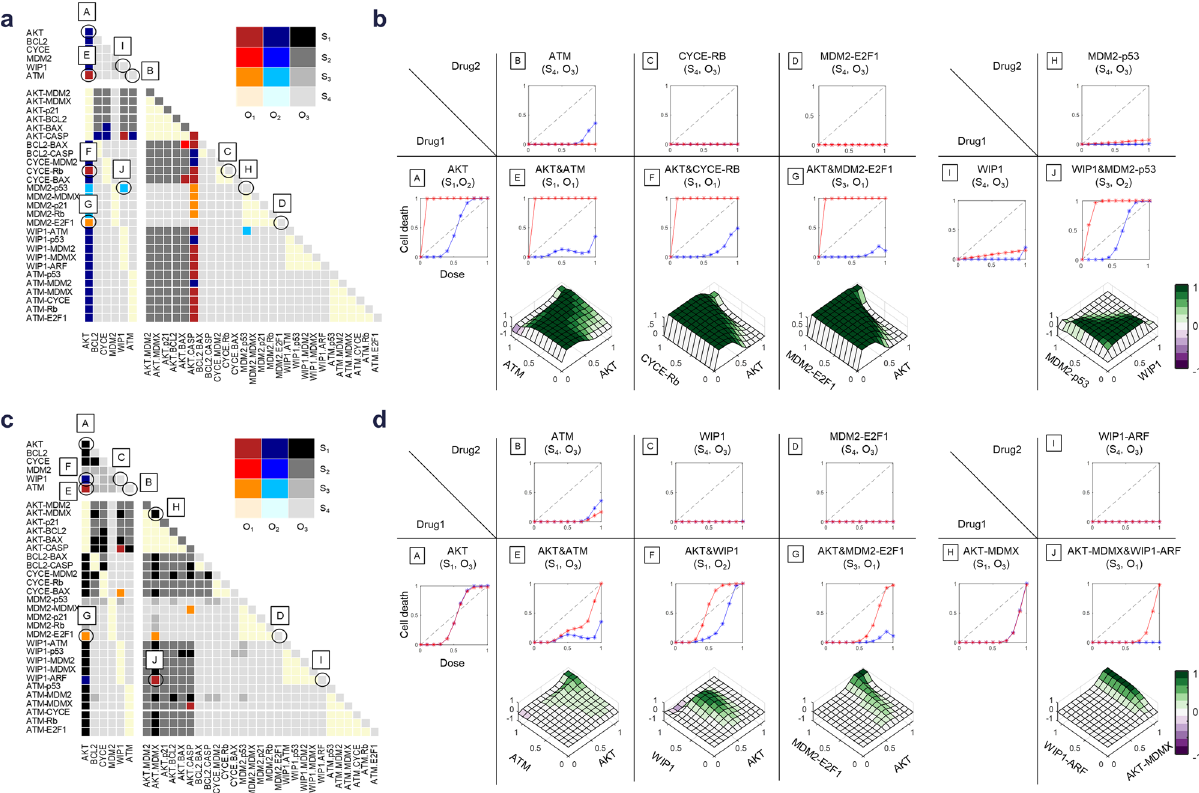
Fig. 4 Drug-target screening by cancer cell network responses to identify targets with therapeutic windows. Analysis of the 480 single and combination perturbations in NT_8 (A, B) and NT_9 (C, D). a , c Triangle maps of the (S n ,O m ) classi fi cation for NT_8 and NT_9. Capital letters in a and c correspond to graphs in b , d , respectively. b , d Dose – response curves and dose – response landscapes for the selected single (A, B, C, D, H, I) and combination (E, F, G, J) perturbations. Red and blue graphs denote dose – response curves of cancer and control network,